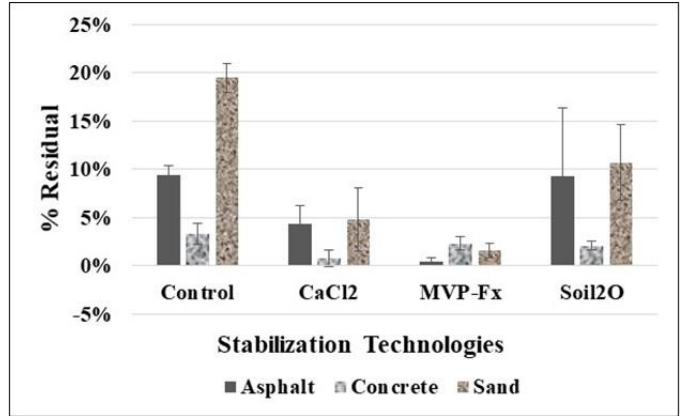
Figure 12. Percent Residual Activity of Sr-85 Contaminated Particles for Vehicle Experiments.